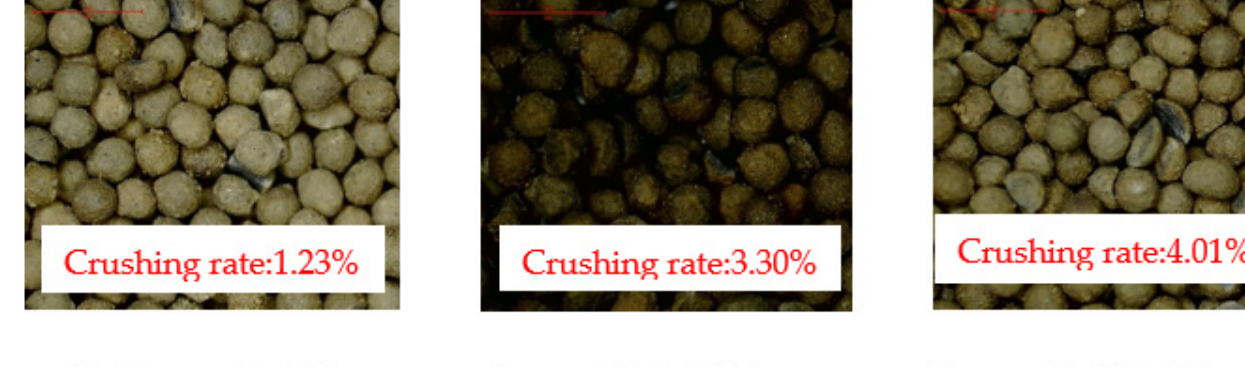
Figure 5. Proppant crushing test results.